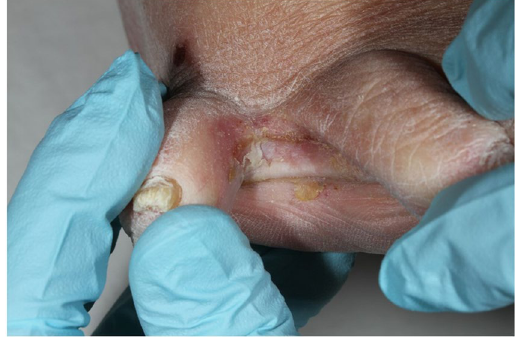
Figure 2. Abnormal skin findings in toe web space; maceration, scales and